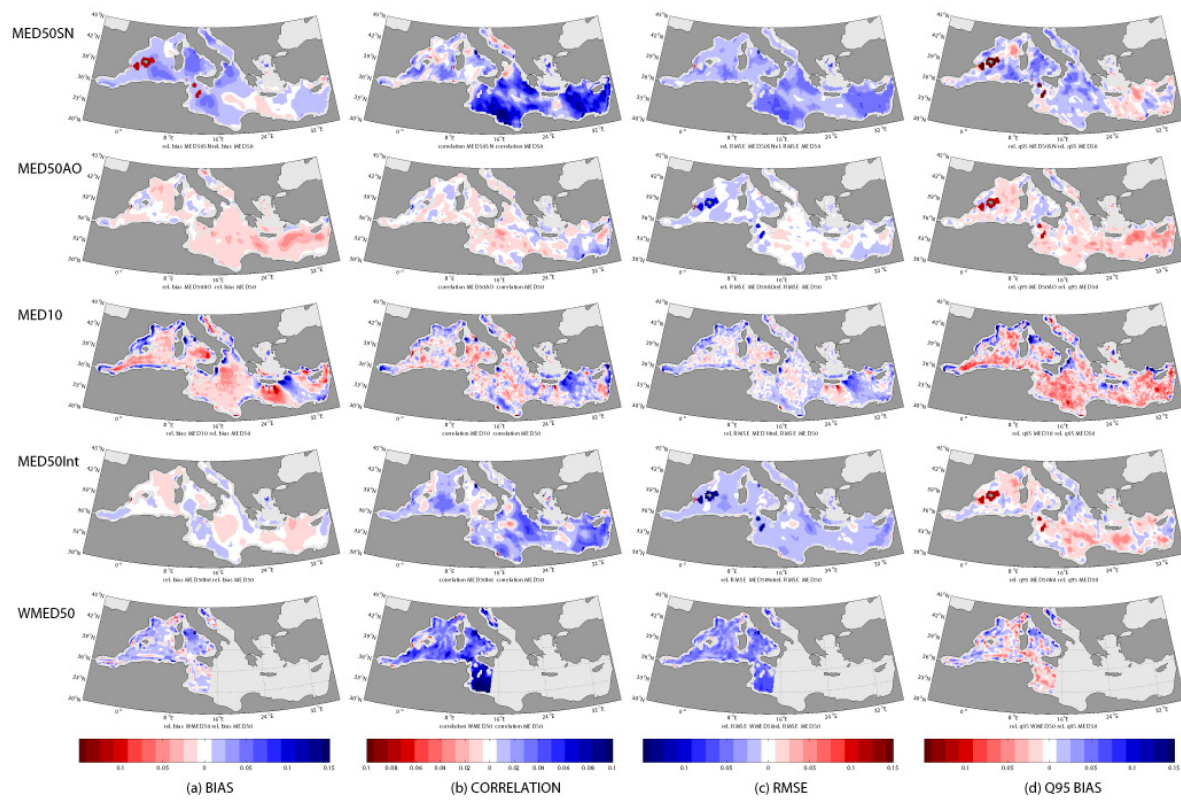
Fig. 7. Relative difference between each simulation and MED50 of the relative bias of the daily wind speed (a) , the correlation (b) , the relative RMSE (c) and the relative 95th percentile bias of the daily wind speed (c) over 2000–2001 compared with QuikSCAT. The colorbar is the same for each map inside a given column. Blue corresponds to an improvement (decrease of the absolute value of the negative bias and q 95 bias, increase of the correlation and decrease of the